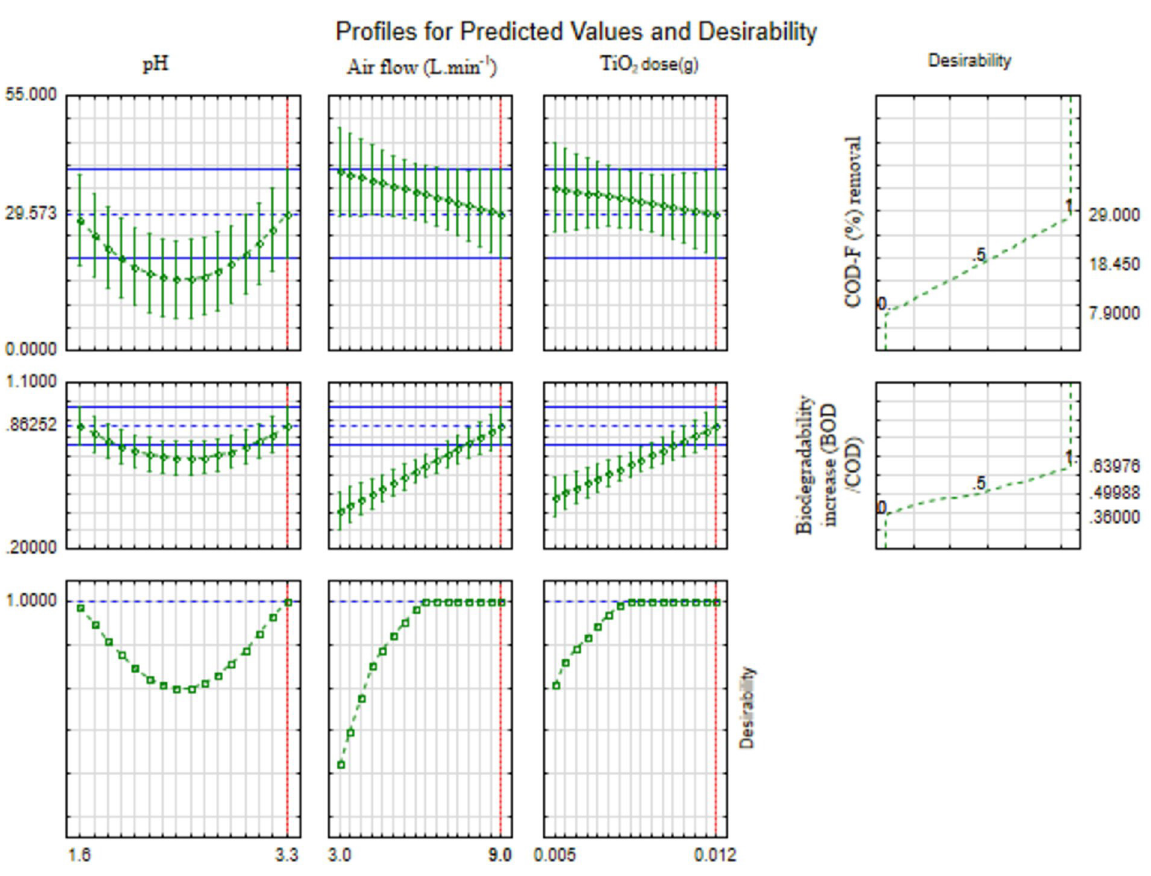
Figure 2. Results of the model desirability function regarding the removal of COD-F (%) and biodegradability increase (BOD/COD) of the data obtained for the process of photocatalytic ozonation in leachate